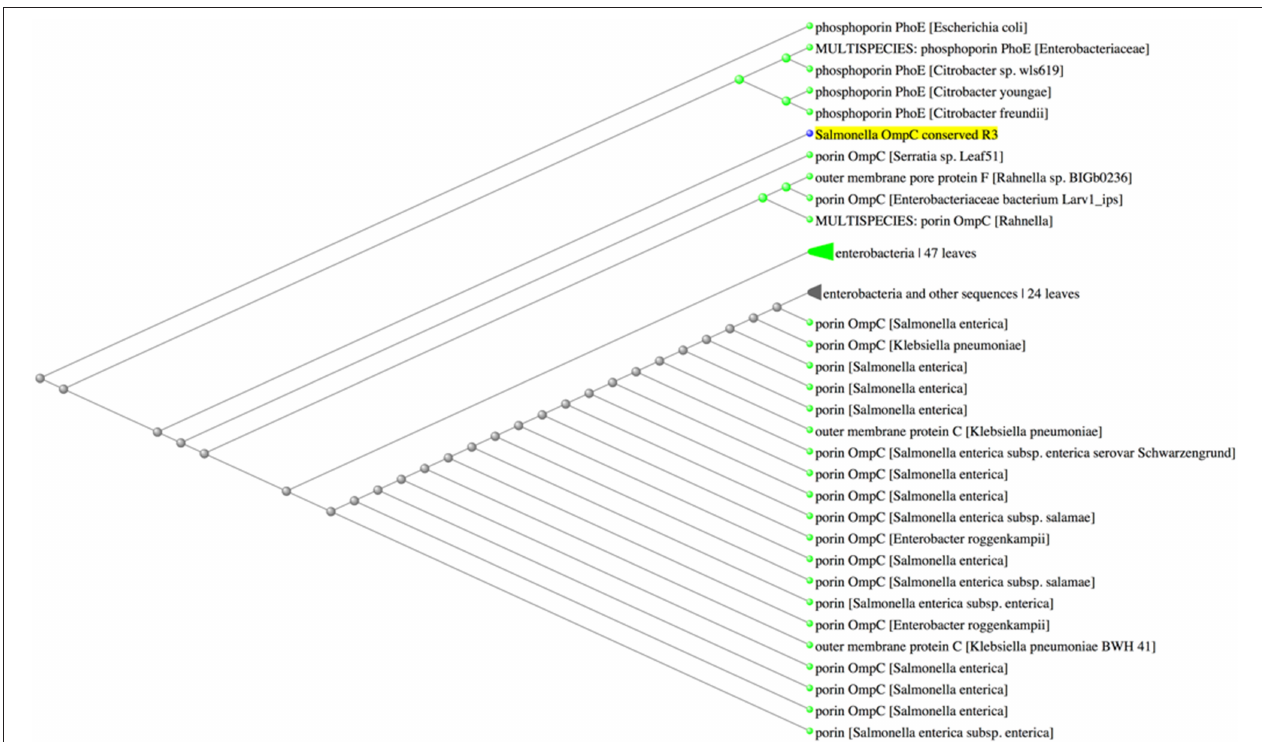
FIGURE 6 | The amino acid sequence of R3 can be found in Salmonella and other Enterobacerial porins. Fast minimum evolution tree between the R3 sequence and the Non-Redundant (nr) GenBank database calculated by BLASTp.